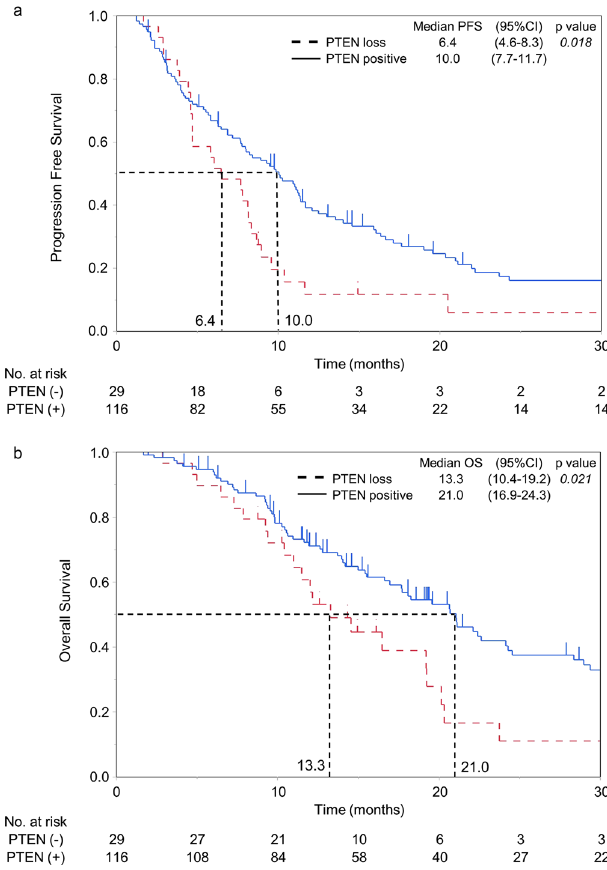
Figure 1. Overall survival (OS) and progression-free survival (PFS) of Tmab-combined chemotherapy (Tmab-CTx). ( a ) OS was calculated from the date when Tmab-based therapy was first administered. ( b ) PFS was defined as the period from the date when Tmab-CTx was first administered to the date when an objective evaluation as “progression” was determined from the review of the patient chart or to patient’s death. Survival curves were obtained using the Kaplan–Meier method and analyzed using the log-rank